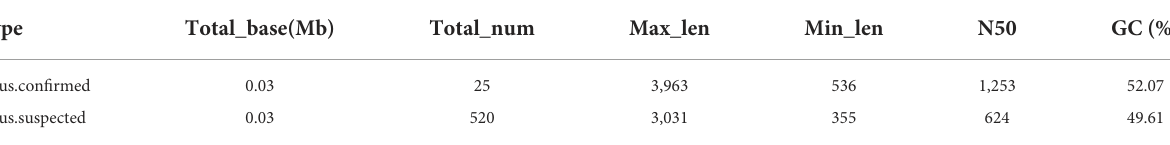
TABLE 4 Statistical analysis of the viral